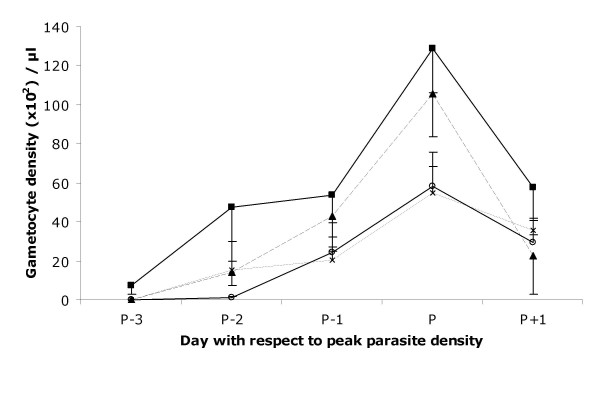
P. gallinaceum gametocyte (sexual) parasite density (mean ± S.E.) following infection by either or both parasite clones using a fixed number of mosquitoes. Thai or SL clone alone, 8 infectious mosquitoes for either clone per bird; mixed infections were initiated using 8 infectious mosquitoes of each clone per bird (8+8) or 4 infectious mosquitoes of each clone per bird (4+4). 3 birds were thus infected for each treatment type and the experiment was performed twice using different batches of mosquitoes infectious for each clone. Thai clone (squares, thin line); SL clone (open circles, thick line); 8+8 mixed clones (triangles, long dotted line); 4+4 mixed clones (crosses, short dotted line).